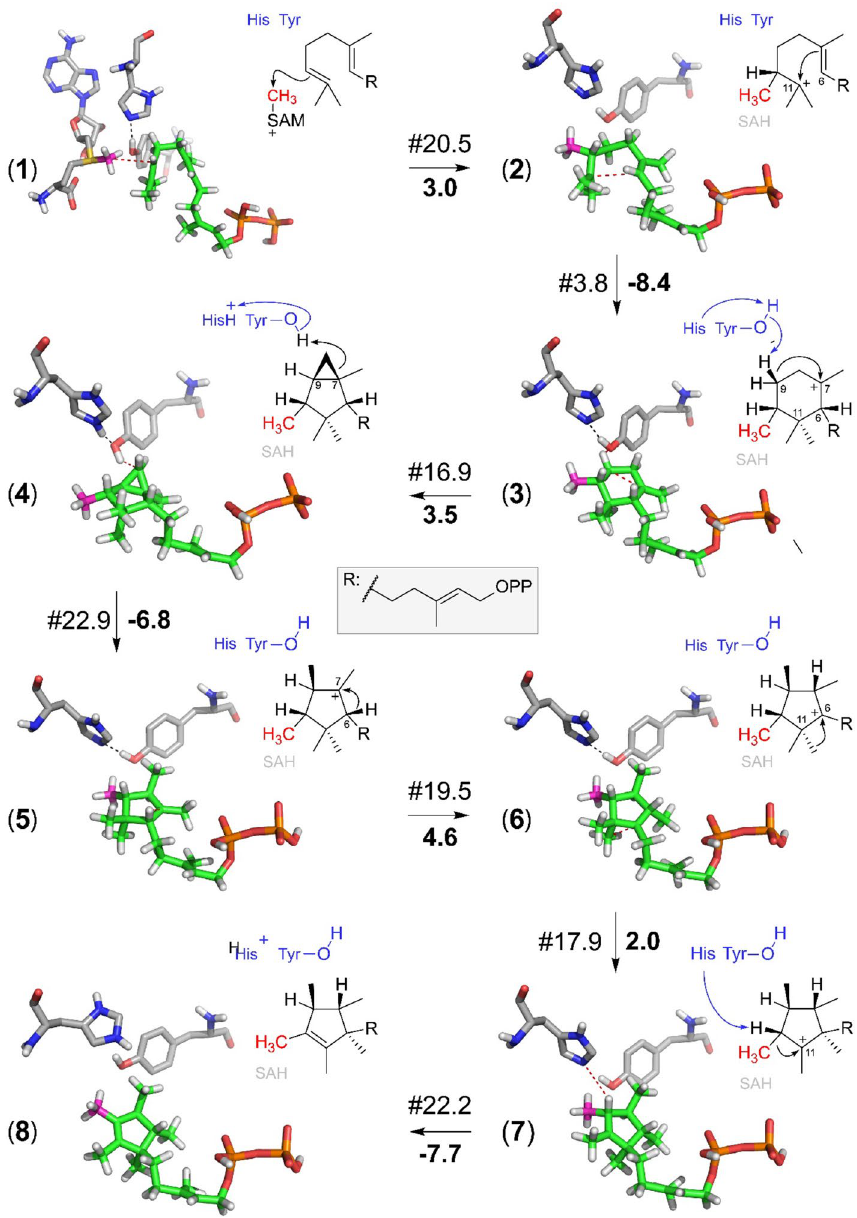
Figure 5. Intermediate steps of the catalytic mechanism for the formation of PSPP by the Serratia plymuthica FPP C -methyltransferase. The PM7 calculations include all atoms of the active site model shown in Fig. 4B. For better visualization only the essential parts are displayed, thus non-polar hydrogen atoms that are not required for the understanding of the mechanism and the formed SAH in reaction steps (2–8) are not displayed in the 3D representations. Below each reaction arrow, the reaction enthalpy is given (in kcal/mol). Above each reaction arrow, the required activation energy (kcal/mol) is indicated by “#”. The reaction starts with the methyl-transfer from SAM (magenta carbon atom) ( 1 ) to the C10 carbon atom of FPP (green carbon atoms). The carbon atom colored in gray attached to FPP is in all 3D figures (steps 2–8 ) the one that has been transferred from SAM. Red dotted lines indicate the reaction coordinates. Histidine (H191) and tyrosine (Y39) are the amino acids that form the essential